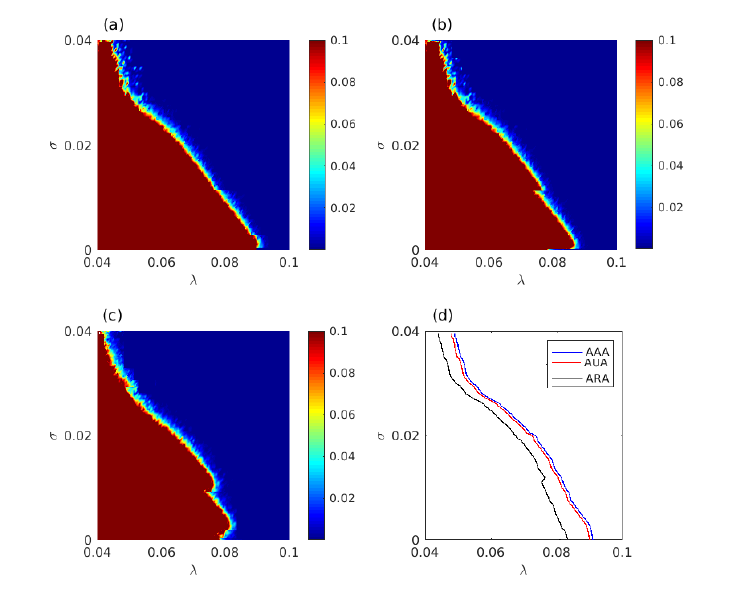
Figure 4. Variation of synchronization error in the ( λ , σ )-plane for ( a ) AAA, ( b ) AUA, and ( c ) ARA configurations. The color bar denotes the variation of the synchronization error E 1, − 1 where the deep red and blue correspond to the desynchronized and synchronized domains, respectively. The subplot ( d ) displays the boundaries of synchronization in the ( λ , σ )-plane for all considered configurations of the triplex relay